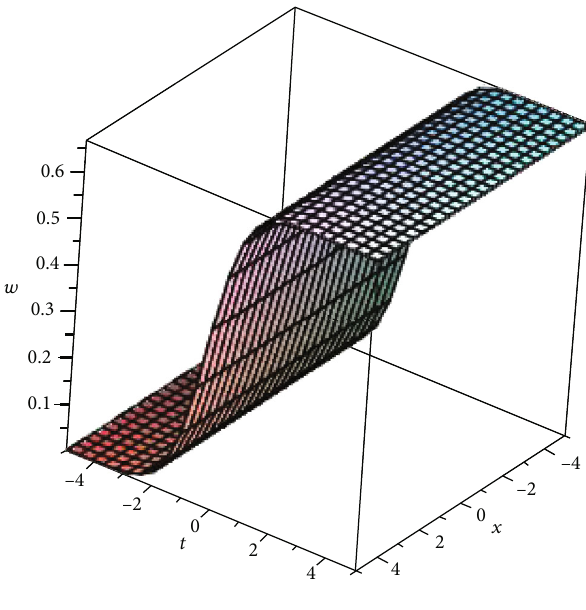
Figure 4: Sol. of (2) given in